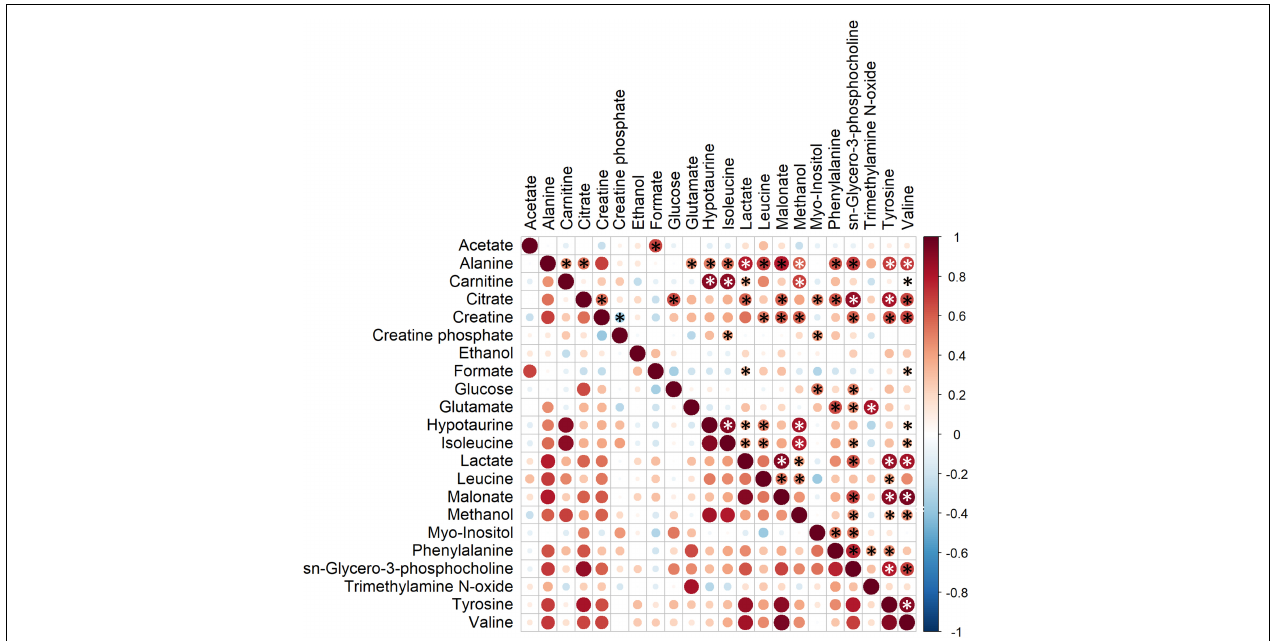
FIGURE 5 | Correlation plot of the twenty-three metabolites identified in boar seminal plasma. The color saturation from red to blue represents the Pearson correlation coefficients (R) between metabolites, from 1 to –1, respectively. Significant correlations ( P < 0.05) are marked with